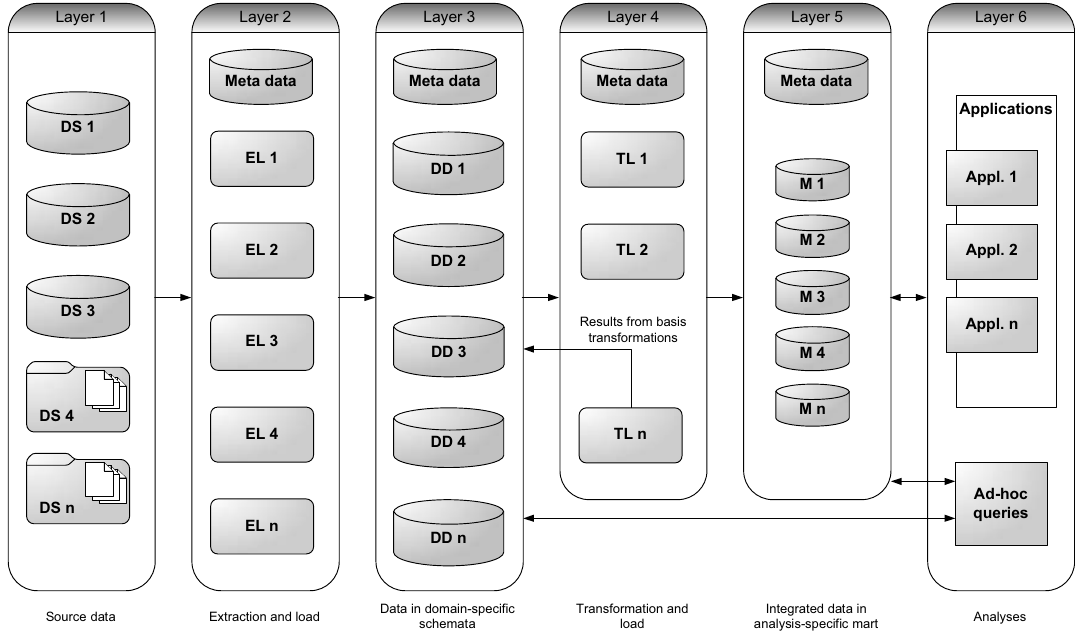
Figure 2: Overview of the proposed architecture. Applications of this architecture are illustrated in Fig.